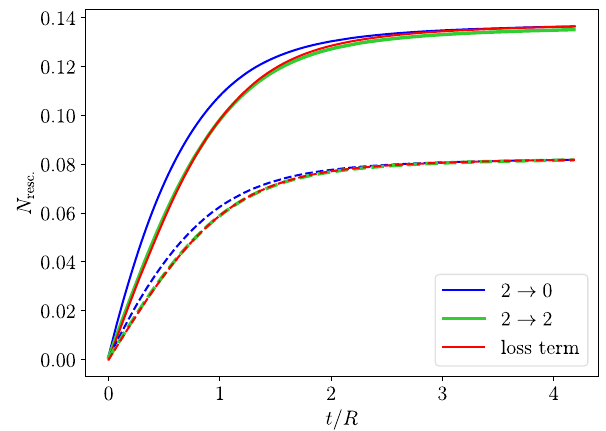
Fig. 2 Time dependence of the cumulative number of rescatterings per particle for systems with in total N resc . ≈ 0 . 14 (full) or 0.08 (dashed) at large times, for simulations with the 2 → 2 (green) and 2 → 0 (blue) models, and using Eq. (13)